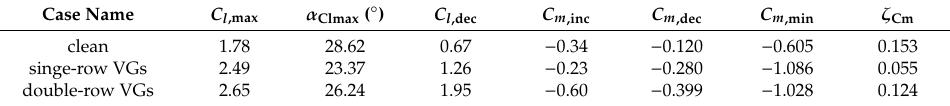
Table 3. Dynamic-stall parameters of the airfoil with and without